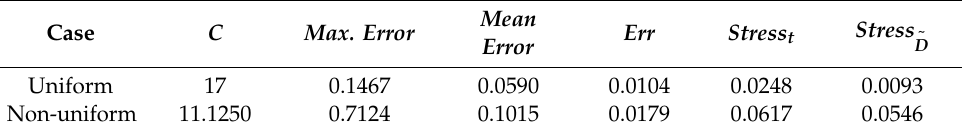
Figure 11. Grid distribution with 25 anchors nodes and seven blind nodes. ( a ) Node locations in one of the iterations. ( b ) WSN graph. Table 3. Uniform vs non-uniform environment of the example in Figure 9.